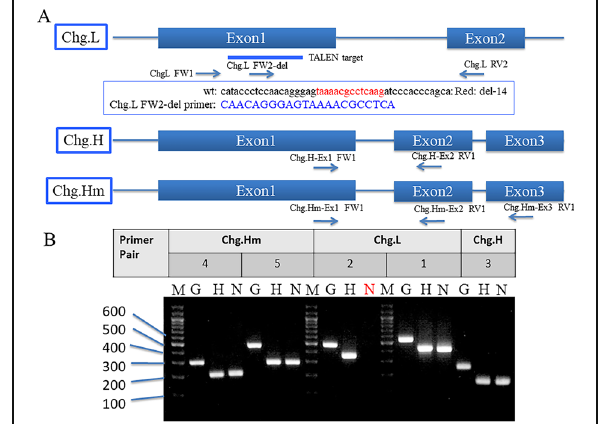
Fig. 2 RT-PCR analysis of chg.l+/ +, chg.l+/ − , and chg.l − / − medaka. A The position of the primers used for the analysis. B The result of RT- PCR analysis of chg.l+/ − and chg.l − / − medaka. Abbreviations: M – marker; G – genomic DNA extracted from the chg.l+/+ fin with sodium hydroxide; H – chg.l+/ − (del-14 heterozygous knockout (KO)); N – chg.l − / − (del-14 homozygous KO). The targeted genes for the RT-PCR assay, primers, size of the cDNA product, and anticipated size of the genomic DNA are summarized in Supplemental Table S2. The primer Pairs for PCR analysis included (1) Chg. L FW1 and Chg. L RV2, (2) Chg. L FW2-del and Chg. L RV2, (3) Chg. H Ex1 FW1 and Chg. H Ex2 RV1, (4) Chg. Hm Ex1 FW1 and Chg. Hm Ex2 RV1, and (5) Chg. Hm Ex1 FW1 and Chg. Hm Ex3